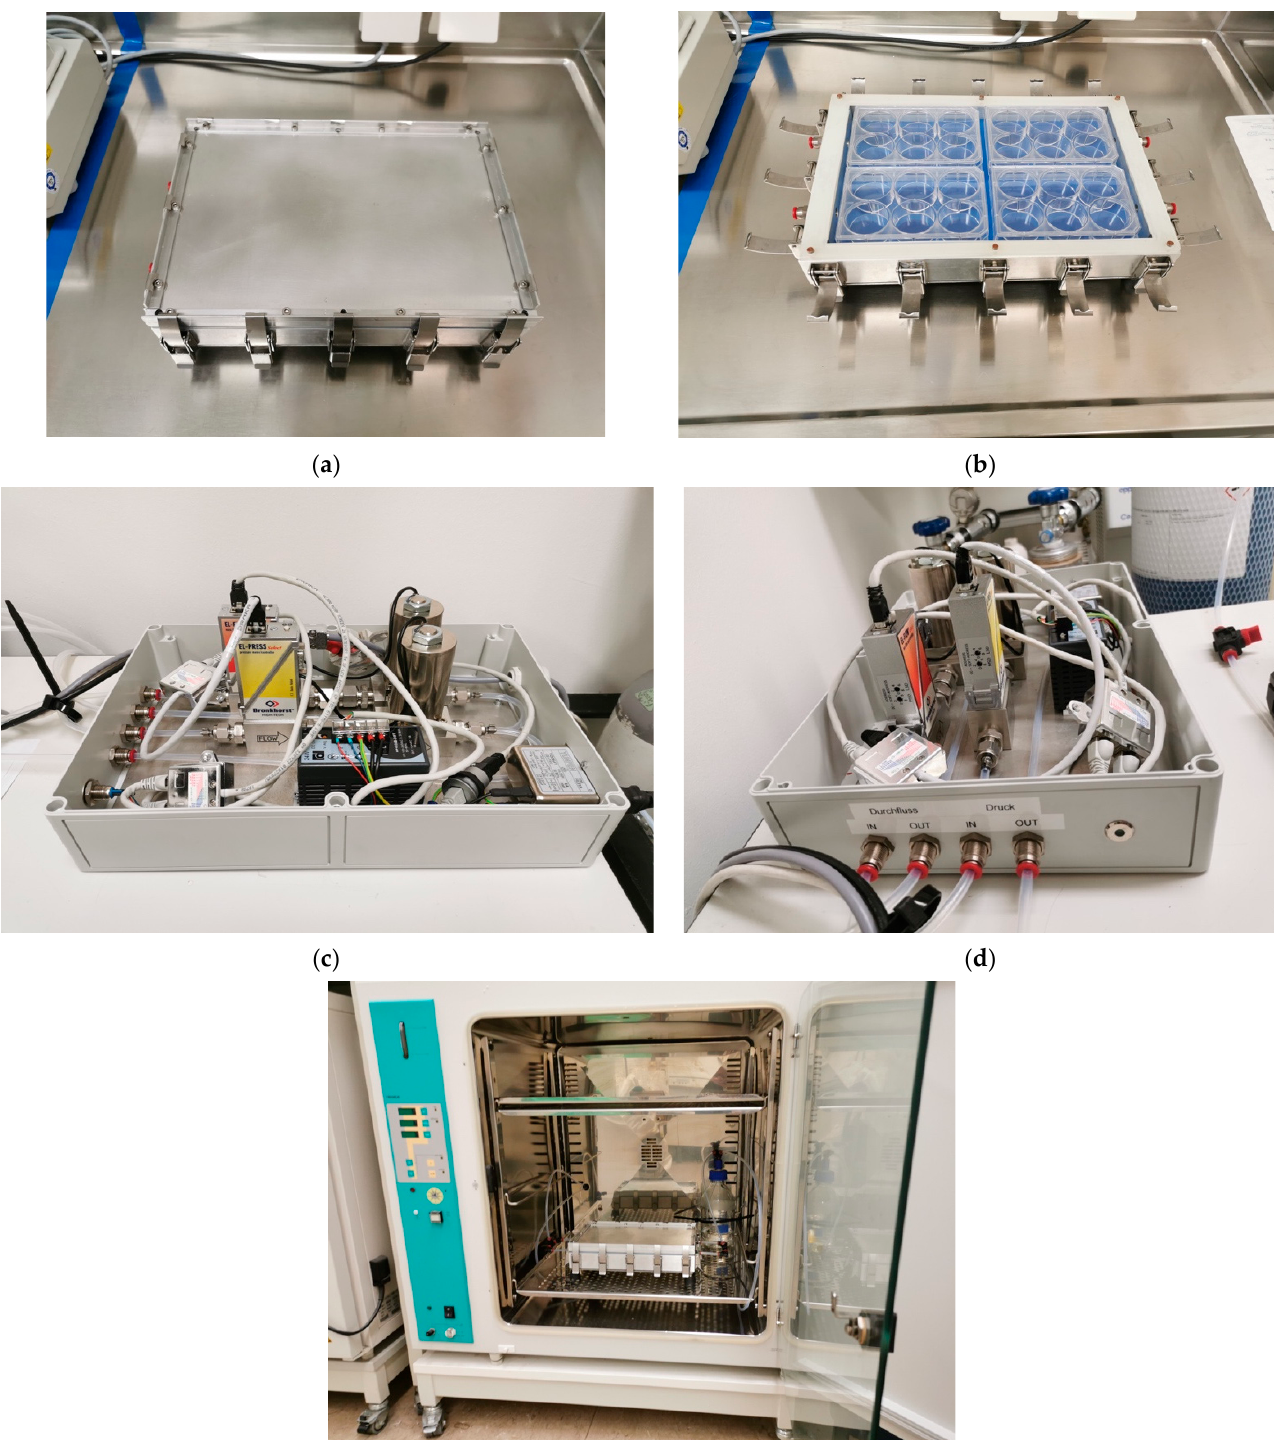
Figure 2. Pressurization system. ( a ) Pressurization chamber with lid; clasps closed. ( b ) Pressurization chamber without lid; clasps open. ( c ) Pressurization chamber control unit. ( d ) Pressurization chamber control unit; German translations: Druck = pressure, Durchfluss = flow. ( e ) Pressurization chamber inside of an incubator.